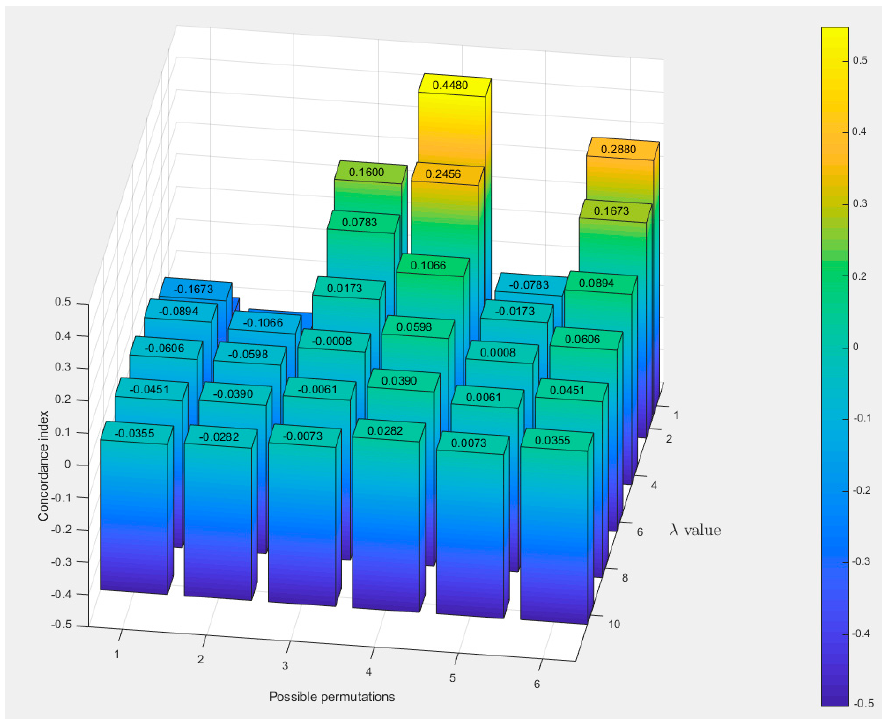
Figure 1. The results of the sensitivity analysis.